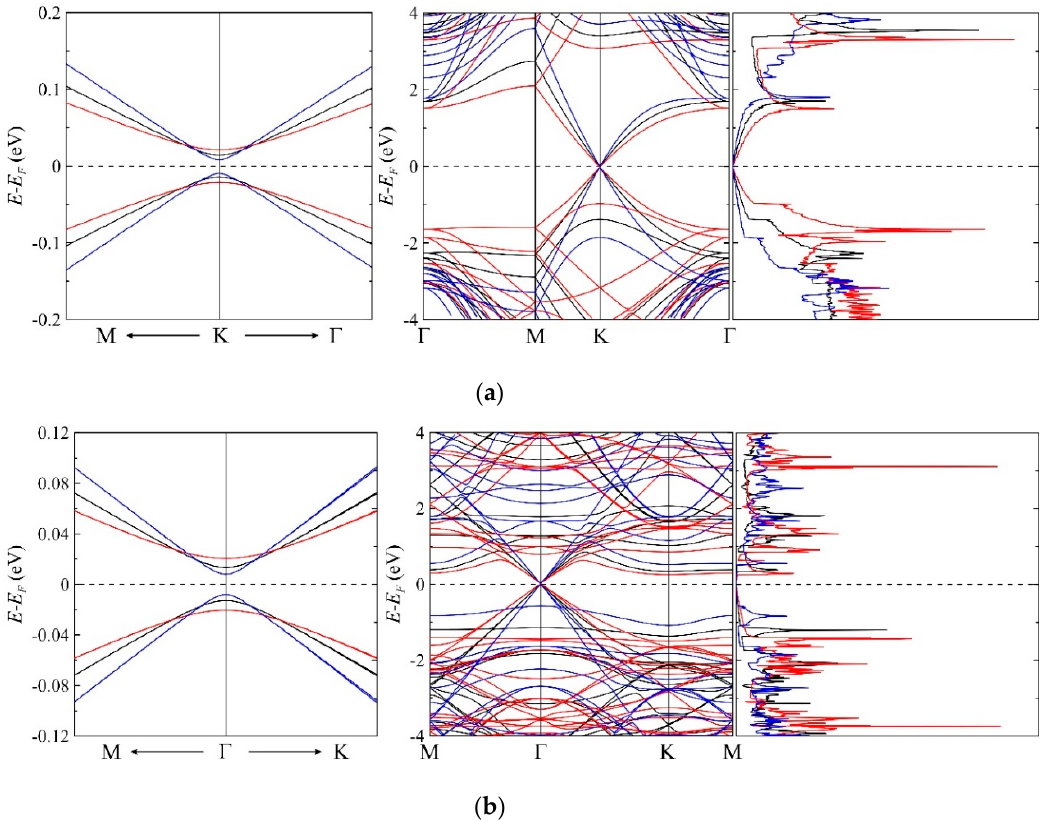
Figure 2. Band structure near the Dirac point (left), band structure (center), and density of electronic states (right) of the graphene deposited on the h BN ( a ) and g C 3 N 4 ( b ) substrates. Blackline corresponds to the unstrained graphene, the blue line corresponds to the 10% compression, and the red line corresponds to the 10% stretching of the graphene sheet on the substrate. Γ , K, and M are the standard notations for the high-symmetry characteristic points in the Brillouin zone, where Γ corresponds to the center of the Brillouin zone. The Fermi level is assigned at zero.